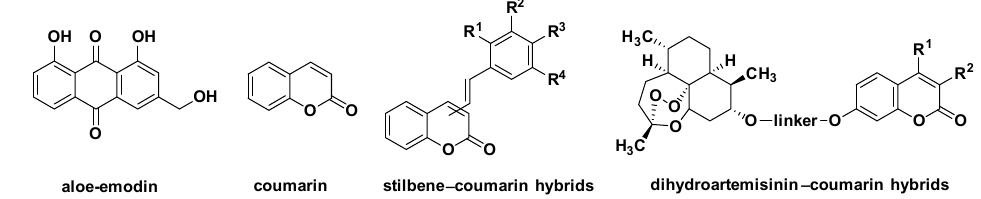
Figure 1. Structures of aloe-emodin, coumarin and the hybrid derivatives of coumarin. Coumarin represents an important class of heterocyclic skeletons, which is widely distributed in diverse natural products. Coumarin-based natural and synthetic